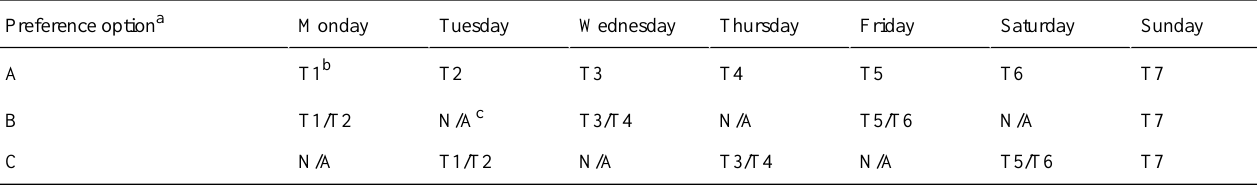
Table 1. Message preference schedules for participant